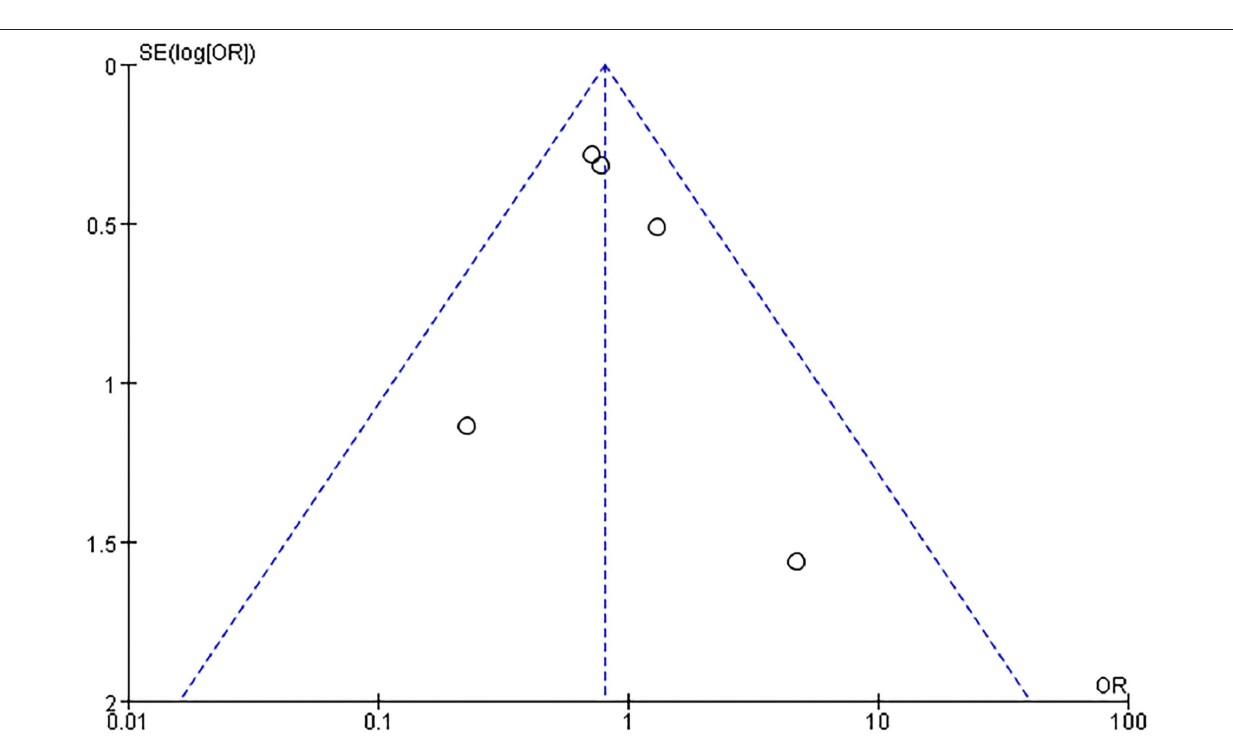
Frontiers in Neurology |